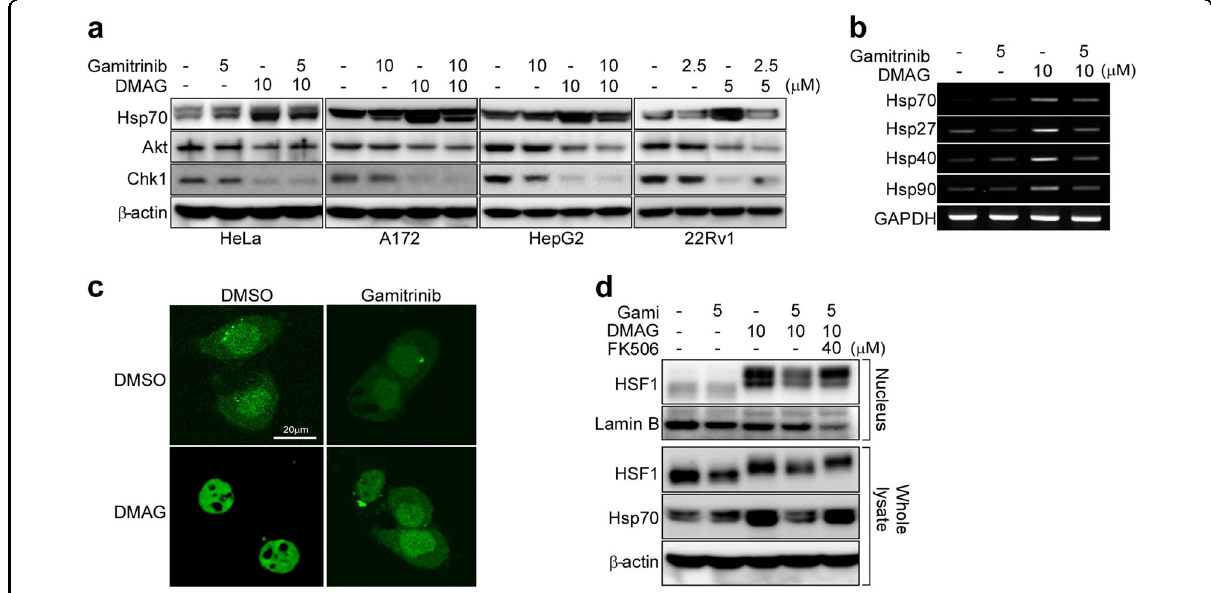
Fig. 3 Combined drug treatment inhibits the nuclear localization of HSF1 and suppresses the induction of Hsp70. a Suppression of Hsp70 in cancer cells by combined drug treatment. HeLa, A172, HepG2, and 22Rv1 cells were treated for 6 h with gamitrinib and DMAG and then analyzed by western blotting. b Expression of HSF1 target genes. 22Rv1 cells were treated for 6 h with gamitrinib and DMAG, and total RNA was isolated and analyzed by reverse transcription PCR. c Nuclear translocation of HSF1. HeLa cells showing transient expression of HSF1-GFP were treated for 6 h with 5 μ M gamitrinib and 10 μ M DMAG, either alone or in combination, and then analyzed by confocal microscopy. Bar, 20 µm. d Hyperphosphorylation of HSF1. HeLa cells were treated for 6 h with gamitrinib, DMAG, and FK506 as indicated. The nuclear fraction (upper) and whole cellular extracts (lower) were analyzed by western